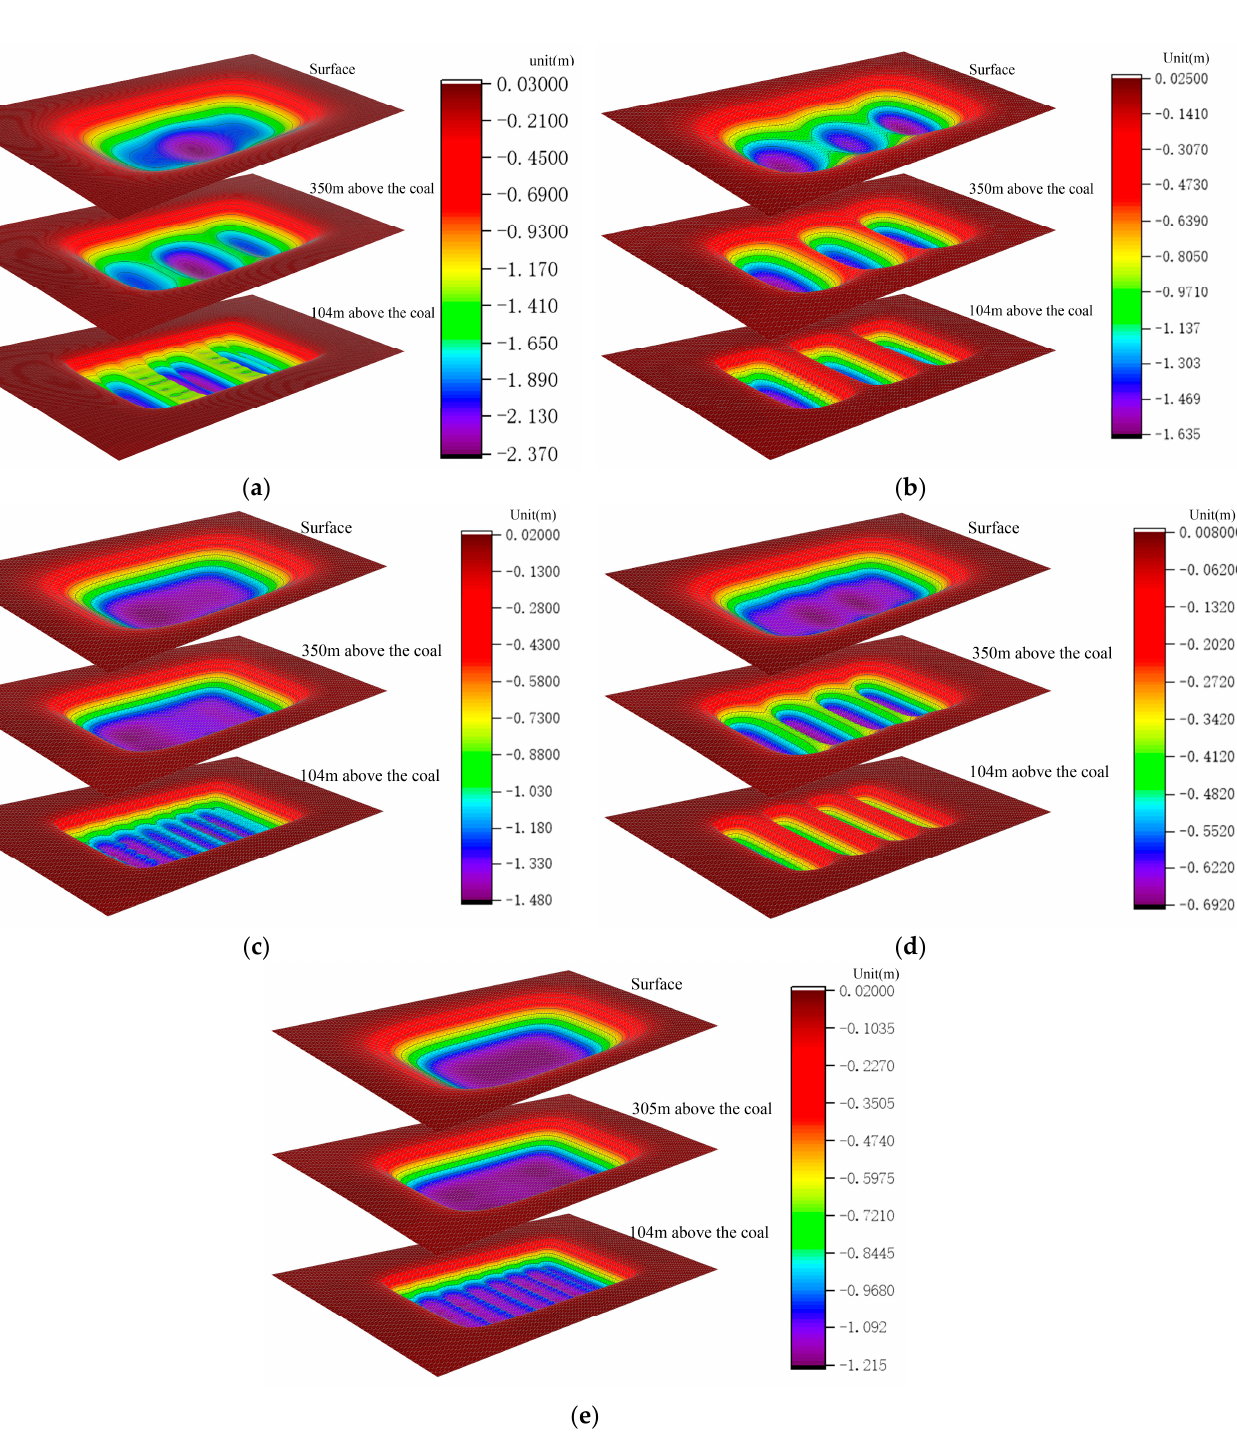
Figure 20. Temporal and spatial evolutionary laws of subsidence spaces; ( a ) partial filling mining. ( b ) Large mining width, small reserved width. ( c ) Mixed filling mining. ( d ) Wide stripe mining. ( e ) Full filling mining. Note that the calculated data were extracted from FLAC3D 5.0 and imported to Origin2018 to draw the subsidence diagrams of rock strata with different buried depths, respectively. Then, the common legend was obtained by the same method. Final, the above subsidence diagrams and legend were imported to Photoshop 2018, and one of the pictures in Figure 20 can be obtained after the typesetting.